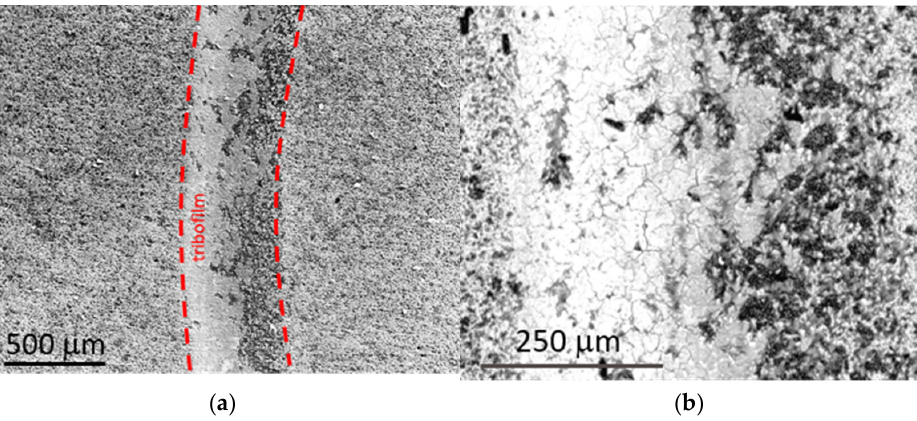
Figure 9. SEM images of the surface of the TiB 2 /20 wt % Ti 5 Si 3 composite after the ball-on disc test: ( a ) general view (low-vacuum SE image); ( b ) magnified SEM image of the wear track area.